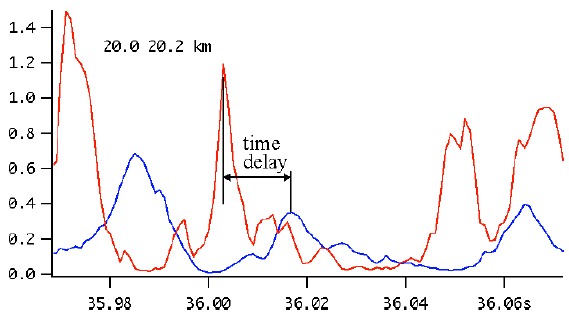
Fig. 55. Sample of blue and red photometer records (103 milliseconds only). The tangent altitude is in the range 20.2 to 20.0 km (200 m vertical range). Note the time delay and the additional smoothing of the blue signal due to larger refractivity bandwidth. Absorption of blue light is stronger due to Rayleigh and aerosol scattering (Dalaudier et al., 2006).